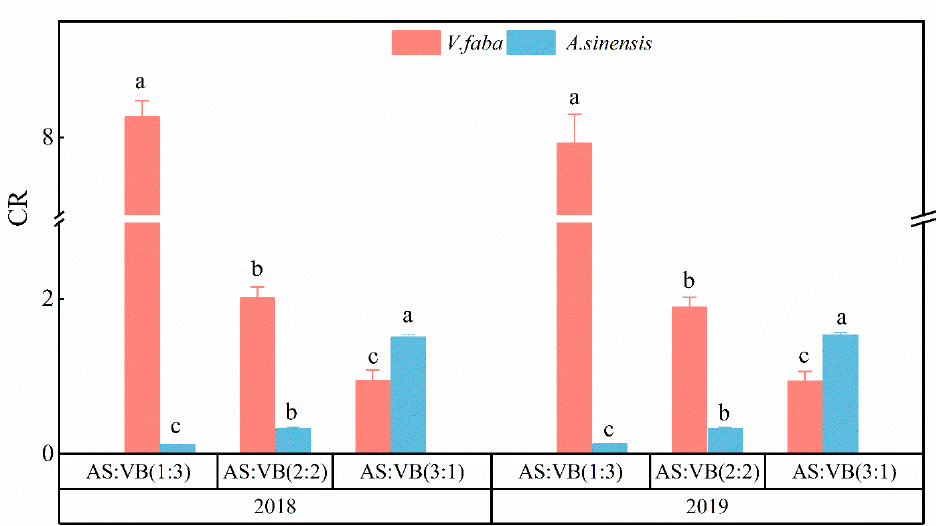
Figure 4. Crowding coefficient (RCC) values in different intercropping patterns in 2018 and in 2019. Within a year, per companion crop, bars bearing the same letter are significantly different at p < 0.05. Error bars represent the standard deviation of the means. AS/VF (3:1), three rows of A. sinensis + one row V. faba ; AS/VF (2:2), two rows of A. sinensis + two rows V. faba ; AS/VF (1:3), one row of A. sinensis + three rows of V. faba .